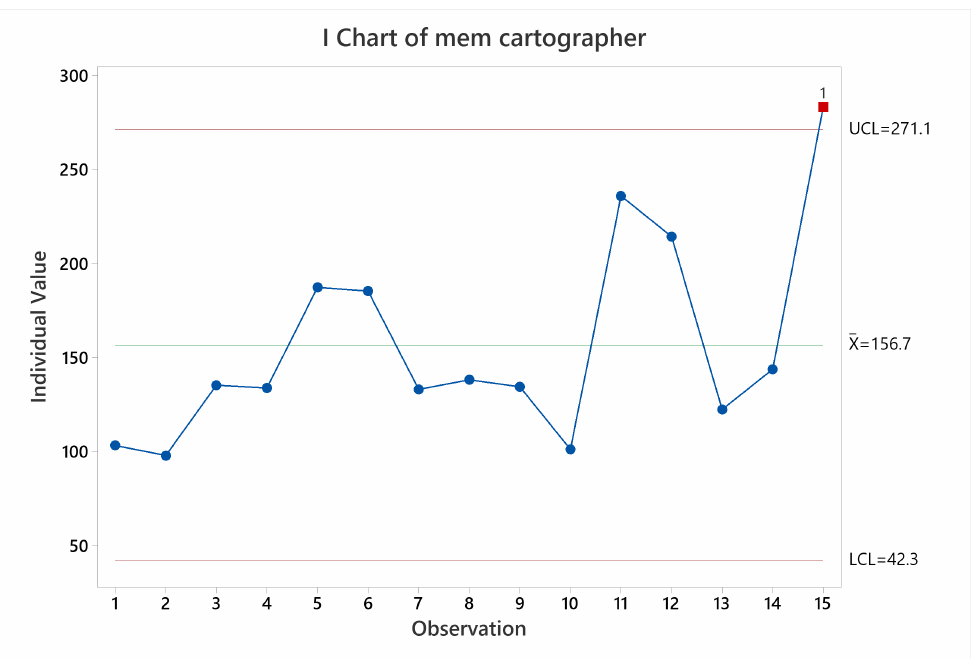
Figure 13. Memory usage mean behavior for